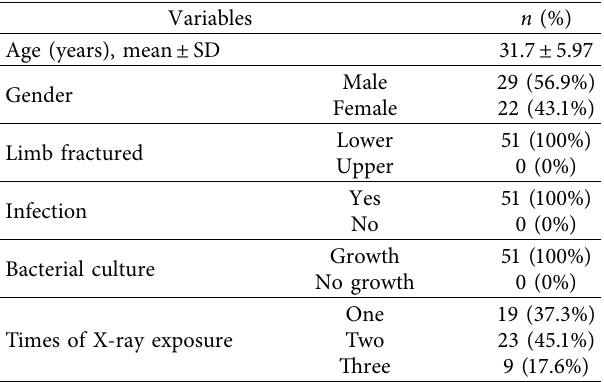
Table 1: Basic demographical and clinical characteristics of 51 patients suffering from open